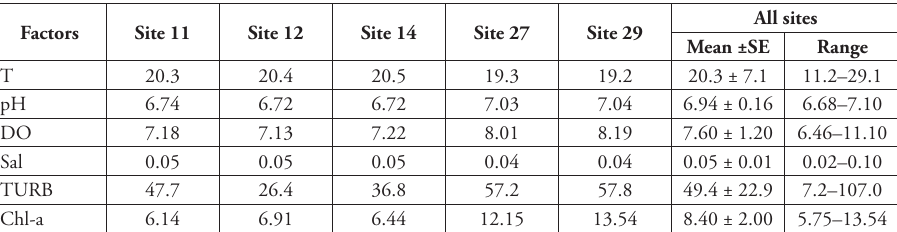
Table 3. Environmental factors of S. carinata (T: temperature; DO: dissolved oxygen; Sal: salinity; TURB: turbidity; Chl-a: Chlorophyll-a).